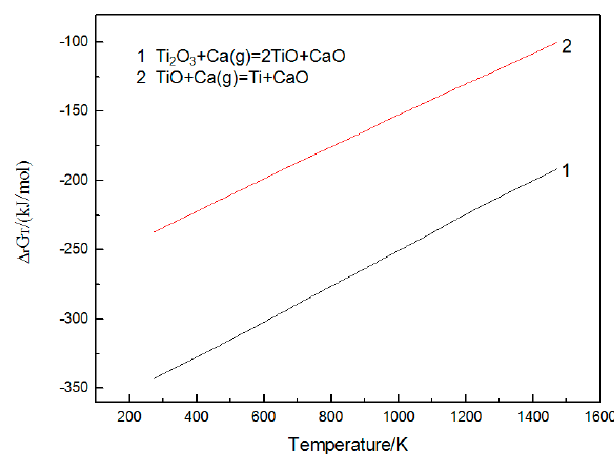
Figure 3. Relationships between Gibbs energy changes and temperature.